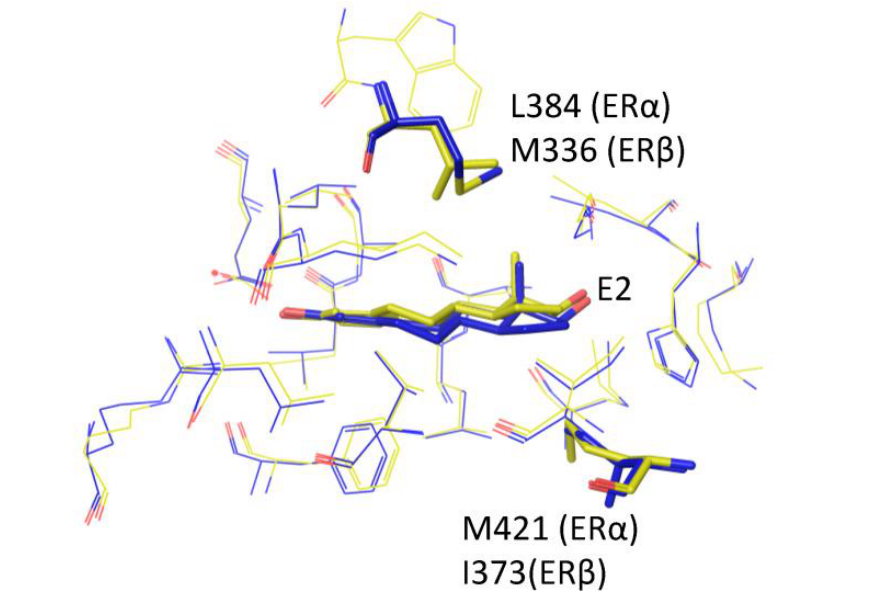
Figure 2. 17β-estradiol (E2) bound to ERα (yellow) and ERβ (blue). Only two residues, i.e. , L384/M336 and M421/I373 (Erα/ERβ), differ in the binding pockets of ERα and ERβ. Unsurprisingly, the E2 binds in the subtypes in only subtlely different